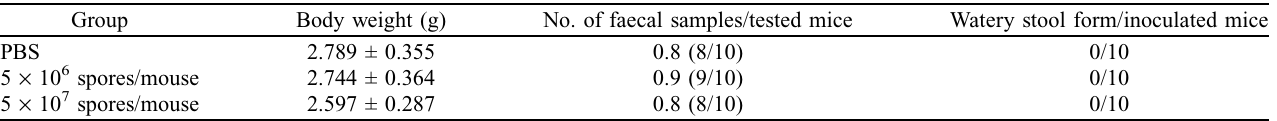
Table 1. Bowel movement results in suckling mice in the groups with phosphate-buffered saline (PBS) or K. septempunctata at 5 · 10 6 or 5 · 10 7 spores/mouse inoculated at 24 hpi.